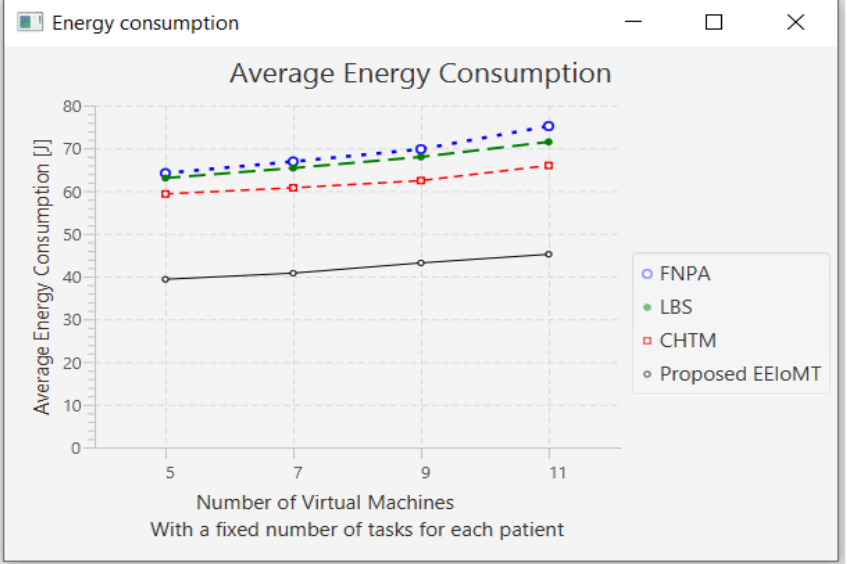
Figure 17. Average energy consumption comparison when changing the number of VMs.